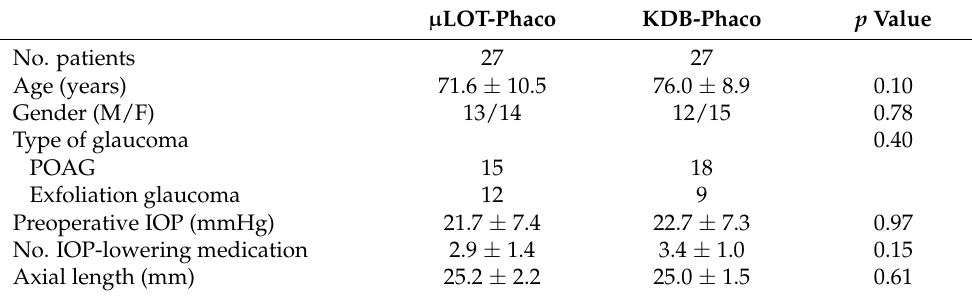
Table 1. Clinical